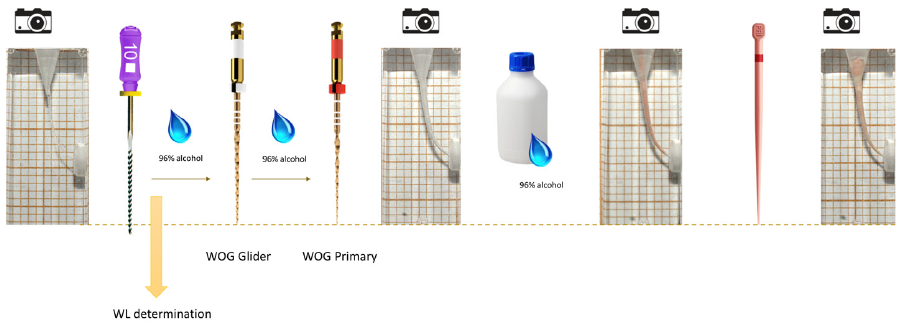
Figure 1. Schematic view of the experimental protocol.